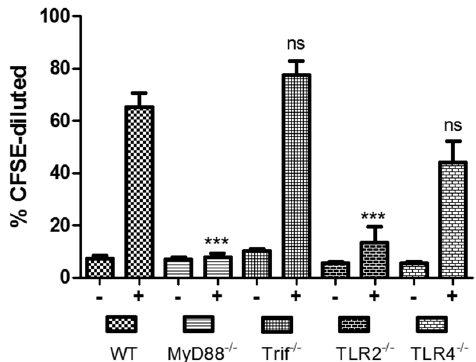
Figure 3. CD4+ T-cell proliferation in response to stimulation by V. cholerae . Splenocytes from